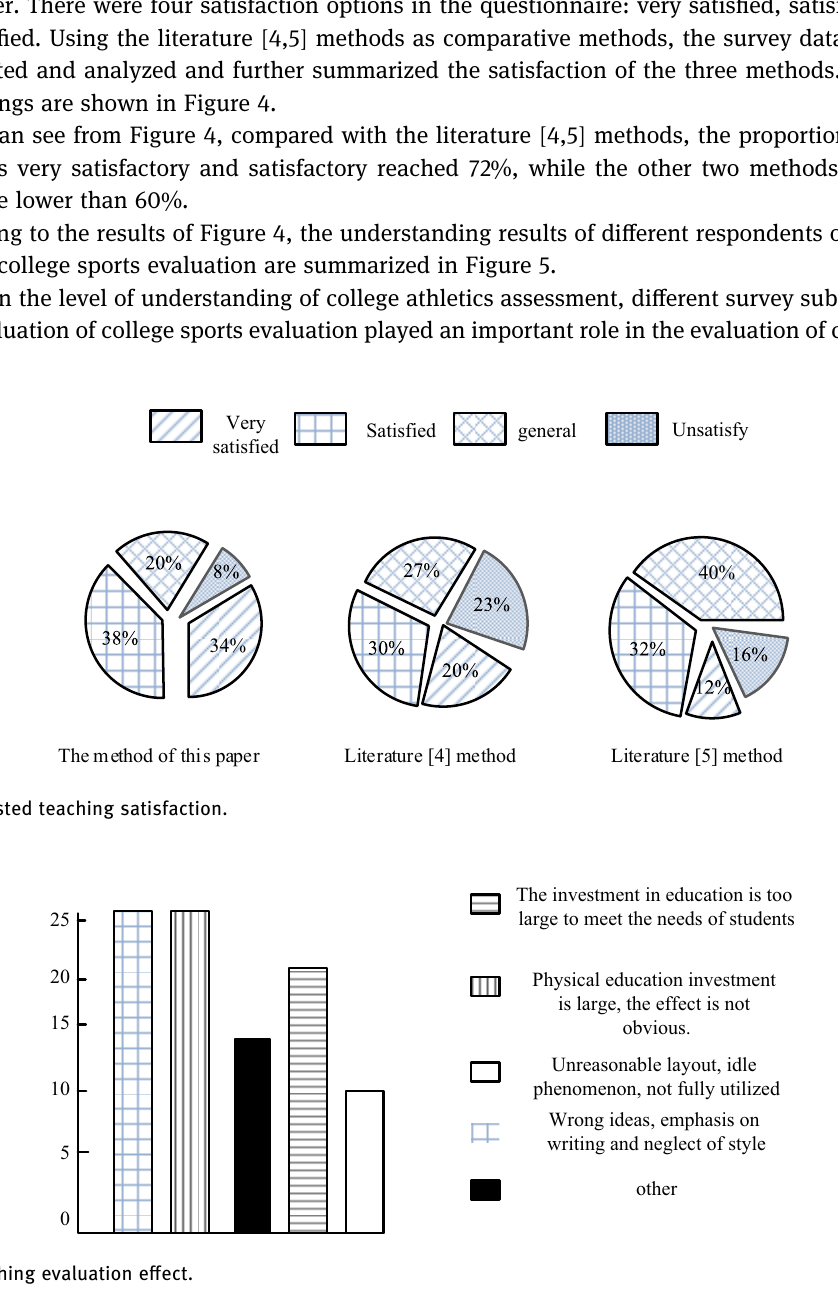
Figure 5: Teaching evaluation e ff